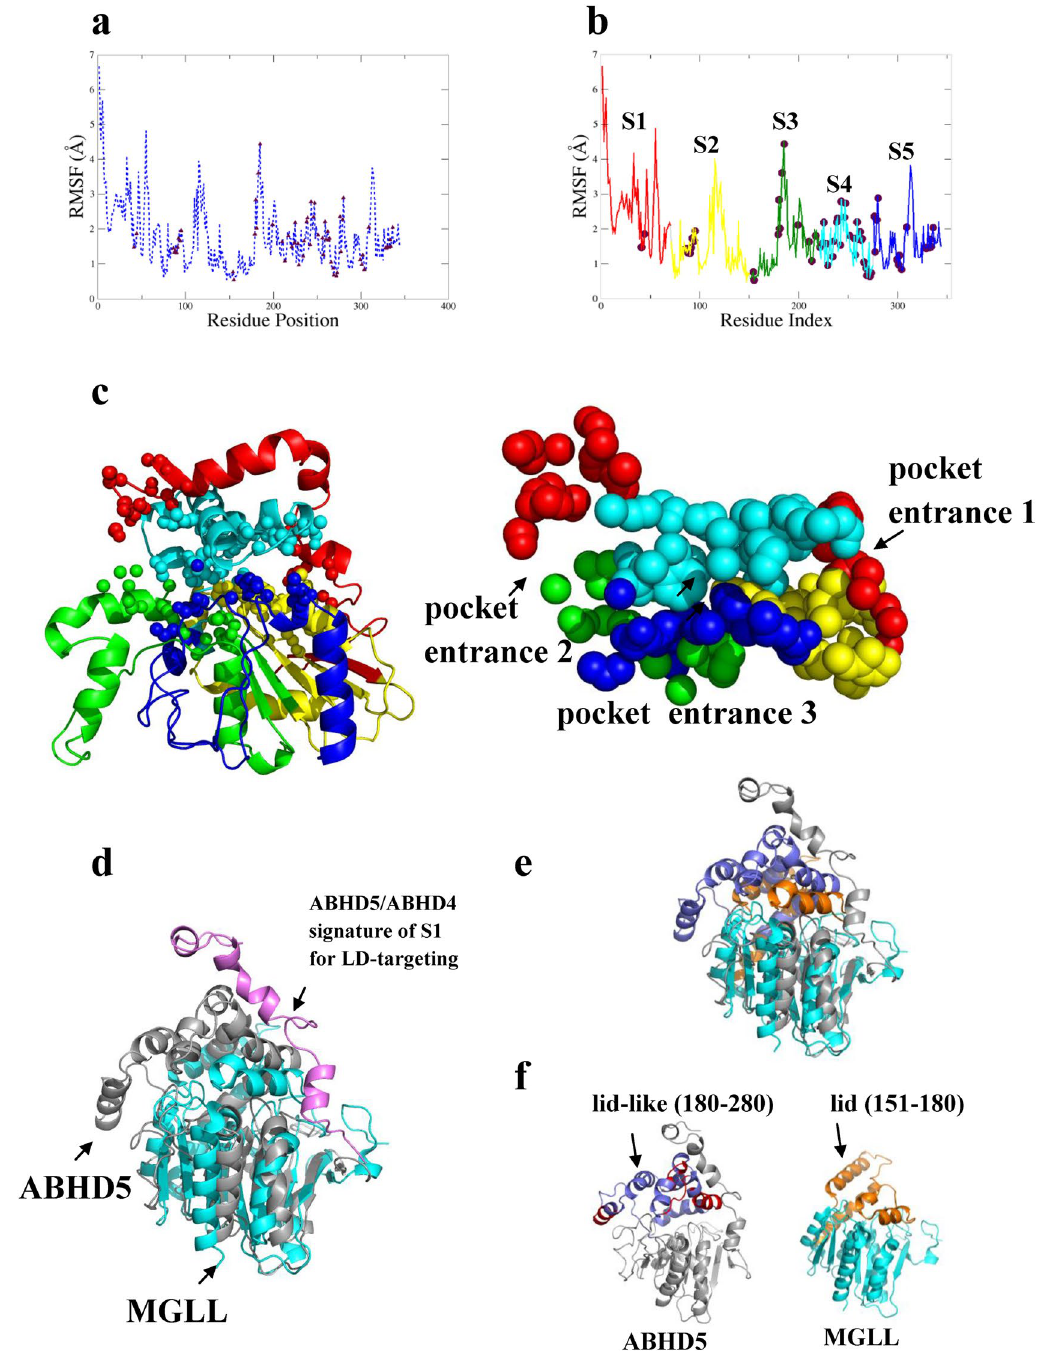
Figure 2. ABHD5 conformations with RMSF analysis. Structural comparisons of conformers were performed to assess residue dynamic movement and contact during MD simulations. ( a ) Pocket residues (brown) exhibited relatively constrained (< 2.5 Å) values of RMSF compared to those of the backbone (blue). Based on the RMSF, the model can be divided into five segments of S1, S2, S3, S4, and S5 as in ( b ). Subsequently, the surface areas of the identified pocket with structural features e.g., pocket mouths were also separated correspondingly in ( c ). The structural alignment between ABHD5 (grey) and MGLL (monoglyceride lipase, E.C 3.1.1.23) in cyan reveals that S1 is a characteristic structural feature (pink) in ( d ) of LD-targeting that has undergone the evolution of subcellular localization on LD membrane. Among ABHD family members, ABHD5 and ABHD4 only have capacity of LD translocation. The structural comparison further unveiled that the distinctive lid (orange) of MGLL is superimposed with the putative lid (blue) in ( e ) of ABHD5 which has a significantly larger lid-like structural feature in ( f ) with additional charged and hydrophobic residues that might be involved in regulation or protein–protein